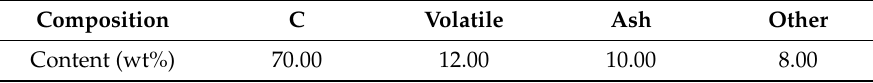
Figure 1. X-ray di ff raction (XRD) pattern of stibnite concentrate. Figure 1. X-ray diffraction (XRD) pattern of stibnite concentrate. Table 2. Chemical composition of reductant coal in pilot scale